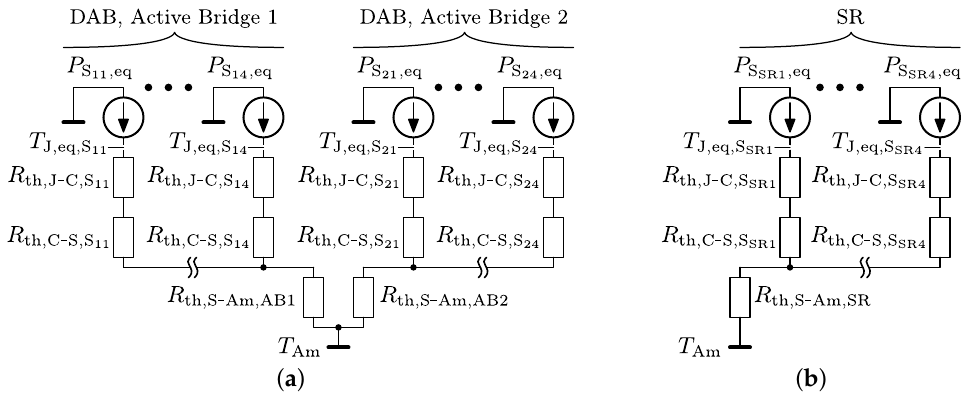
Figure 9. Stationary heat transfer model of the heat sink assembly of ( a ) the DAB and ( b ) the SR.